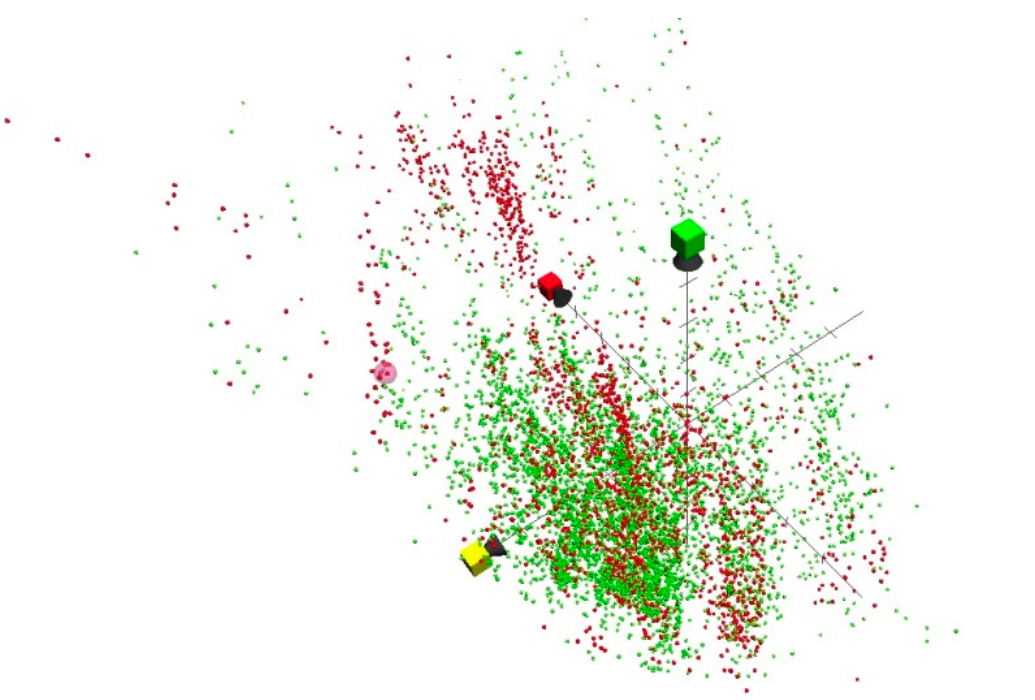
Figure 4. Red and green speckles represent mycobacterium permeability and impermeability, re- spectively. The large pink sphere represents the bedaquiline position in the chemical property space constructed by ChemGPS-NP for natural compounds.